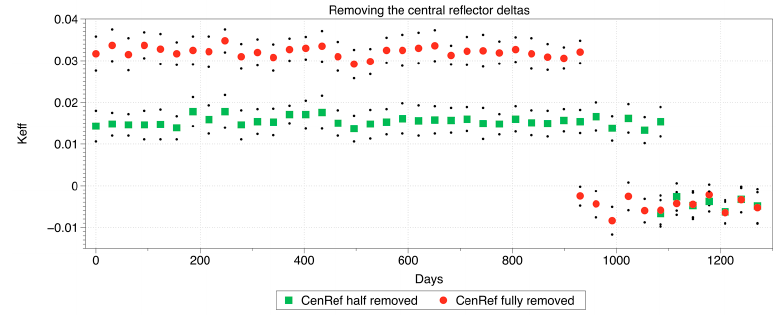
Figure 7. Compact monitored for the 239 Pu build up analysis.